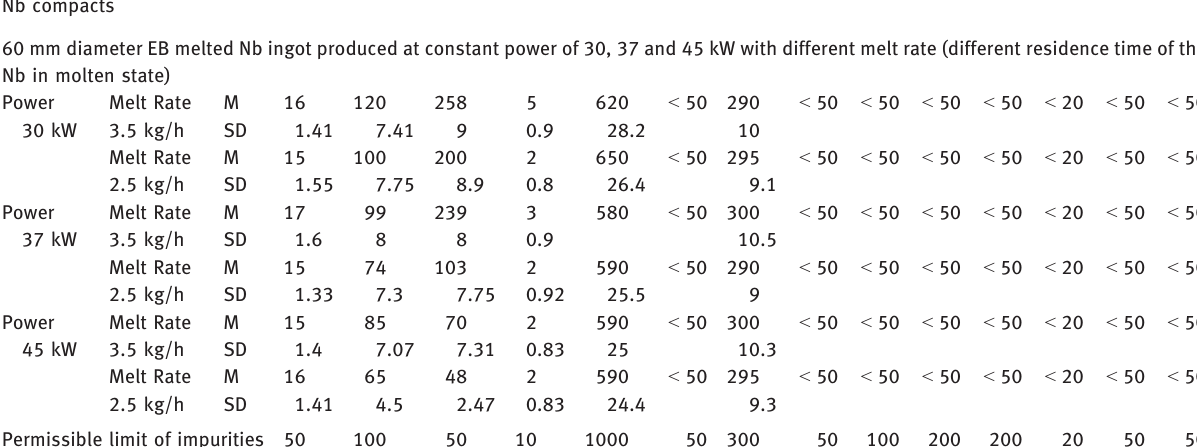
Table 4: Chemical analysis of impure Nb powder, CIPed and vacuum sintered Nb compacts and 60 mm diameter EB melted Nb ingot produced at different melt rate. Impurity element Impure Nb powder CIPed and vacuum sintered